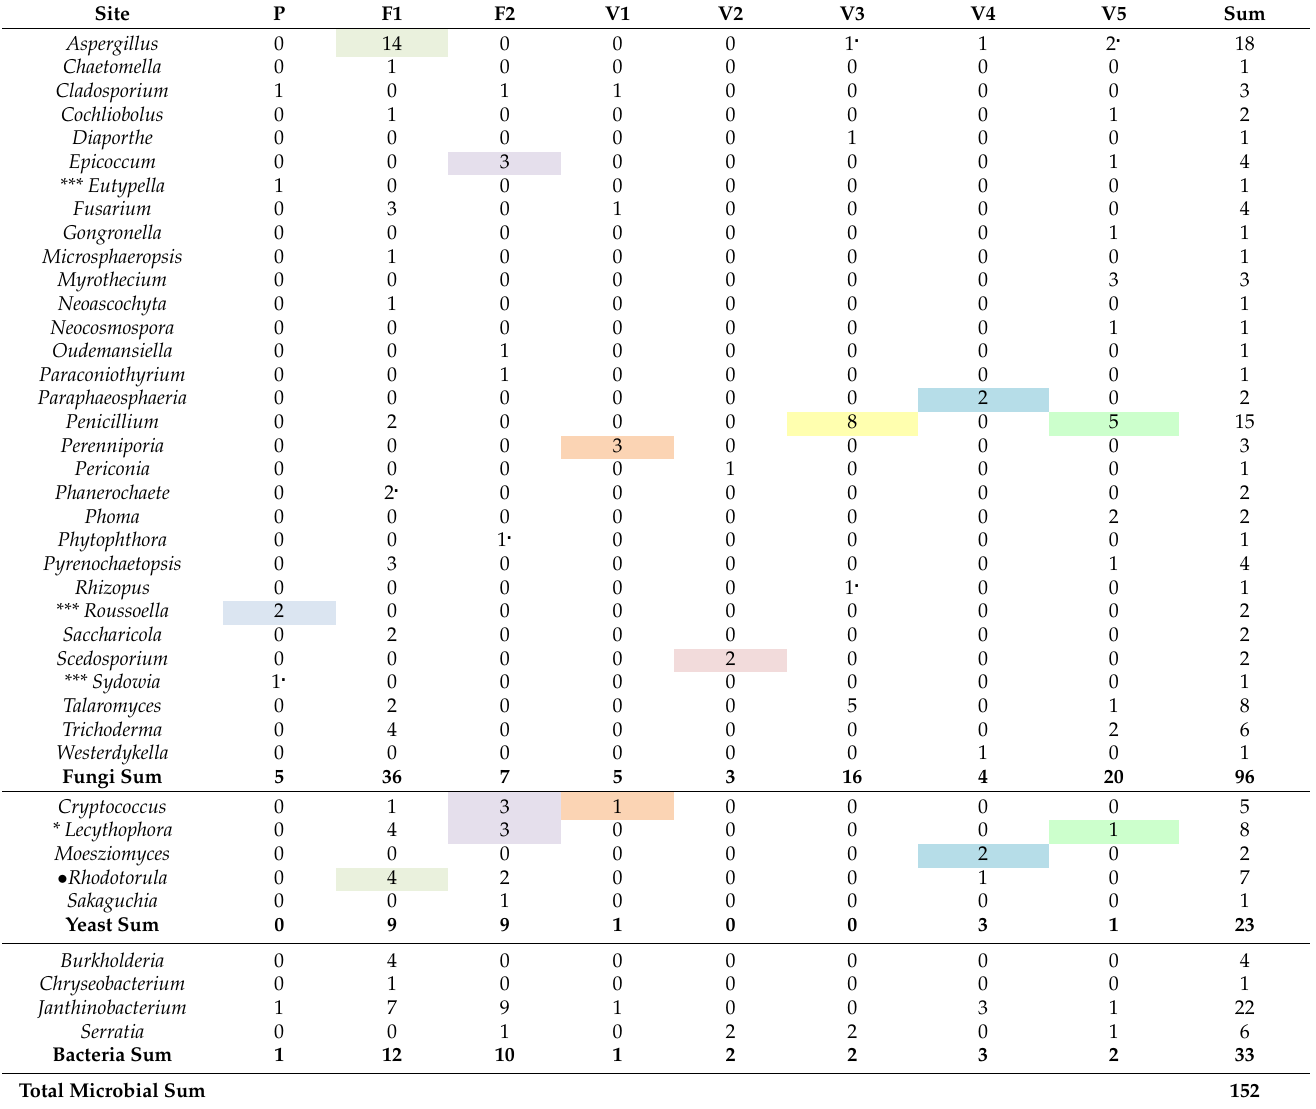
Table 5. Top crude-oil-degrading genera in the 8 sites in southwestern Trinidad.